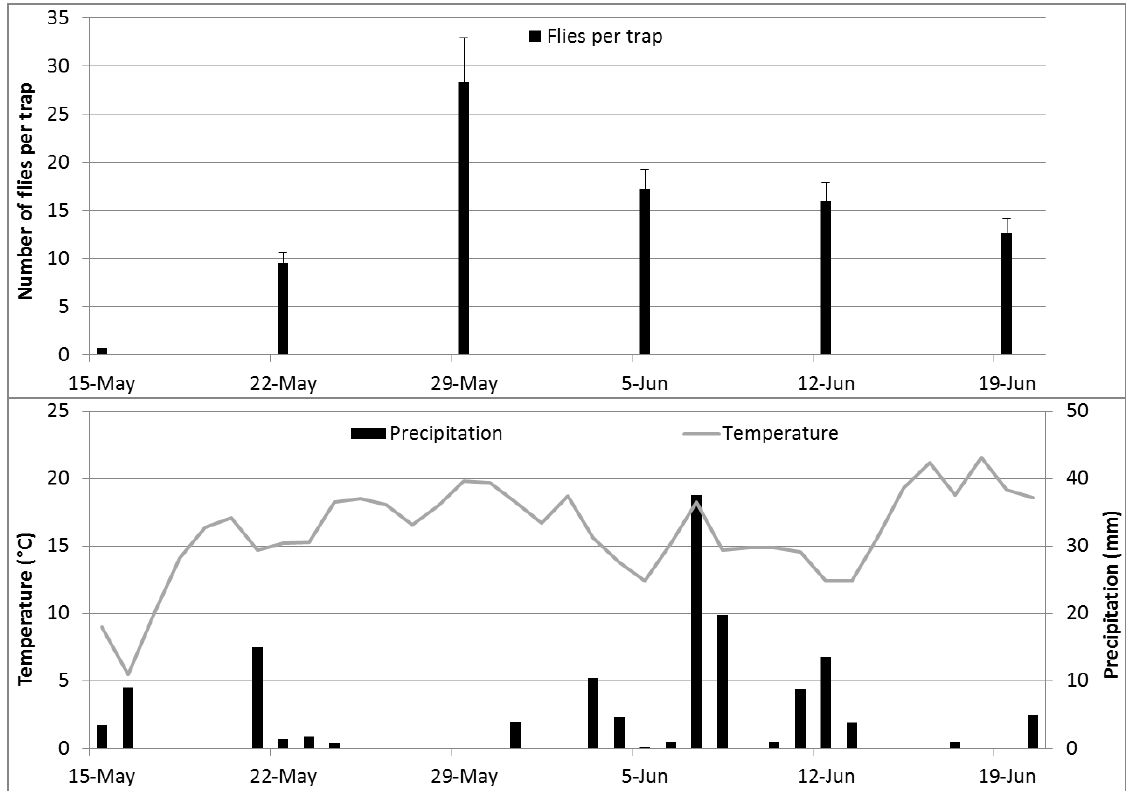
Figure 3. The climatic conditions and cherry fruit fly catches (average over all experimental traps + SE) during the experimental period in